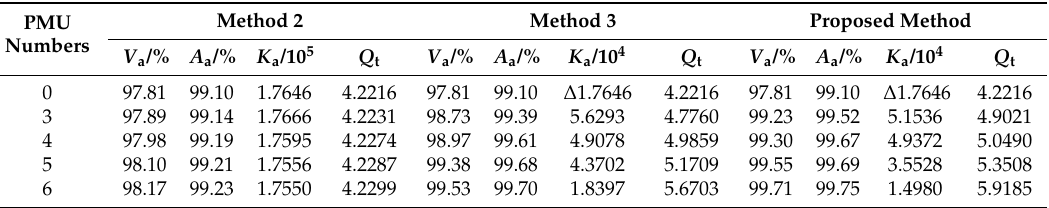
Table 7. The results of state estimation of different cases in 30 bus system.